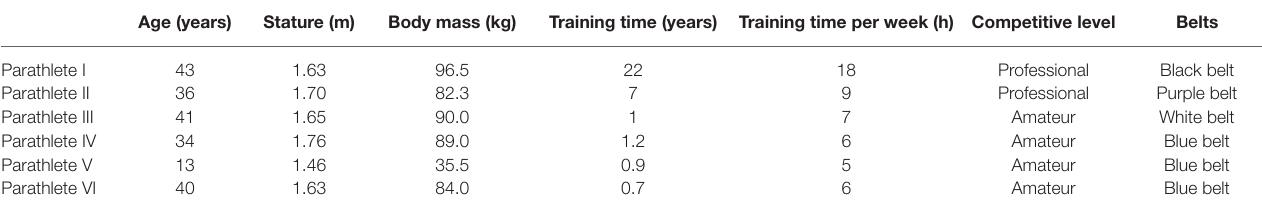
TABLE 1 | Anthropometric characteristics of participants.